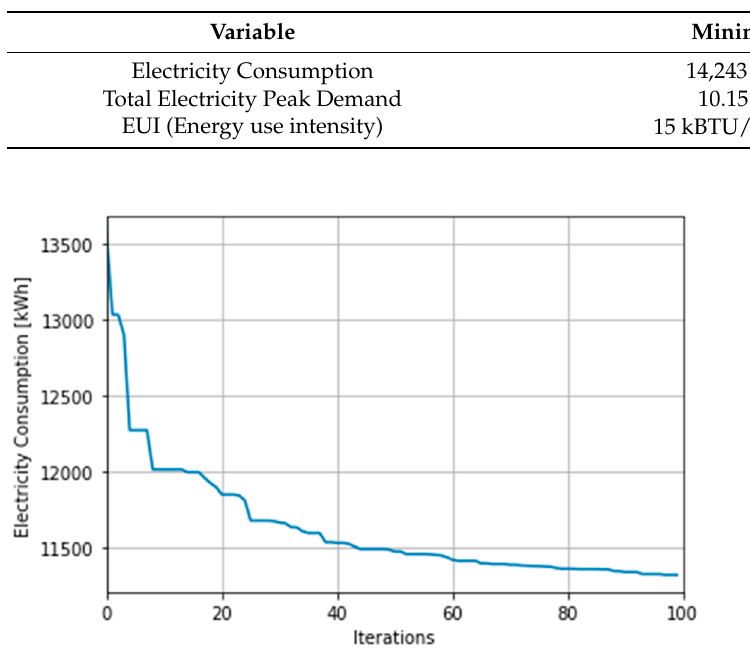
Figure 7. Minimizing building’s energy consumption (surrogate model) using genetic algorithm.